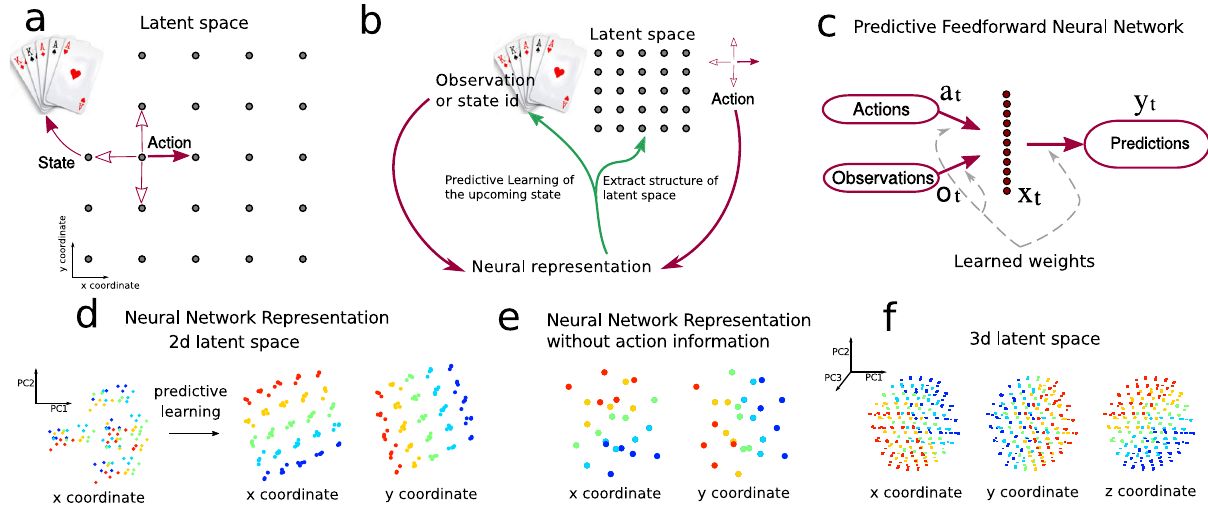
Fig. 1 Predictive network solving a card-game task. a Description of the latent space underlying the task. b Illustration of the task and information fl ow diagram: the neural representation receives state observations and actions and extracts the latent space structure by means of predicting upcoming observations. c Diagram of the network ’ s structure. The diagram highlights the layer studied here, although the network has a two layers, where the second layer serves as a decoder. d The network ’ s neural representation: activity in the hidden layer plotted vs. principal components PCs 1 and 2 of hidden layer activity. For each observation-action pair ( o t , a t ), the corresponding activation is colored by the position of the state that the network predicts: x-coordinate (left plot, before and after learning) and y-coordinate (right plot). e Same as panel d in the absence of the action as a input to the network. f Same as panel d for a three-dimensional latent